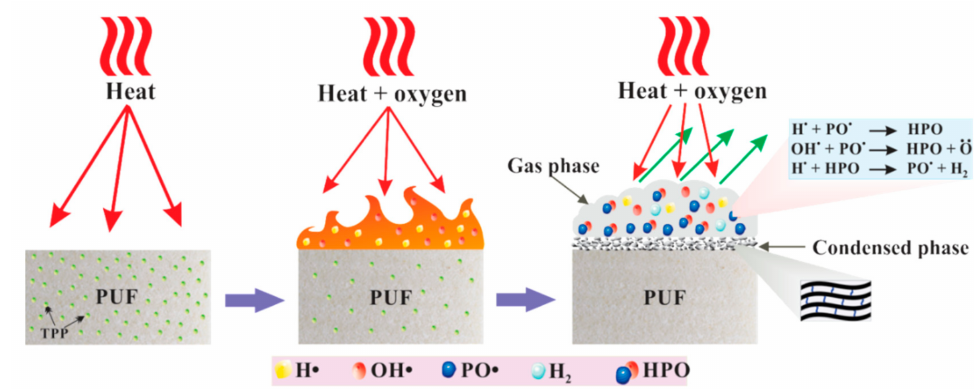
Figure 11. Schematic illustration of the flame-retardant mode of action of PU-DZS-TPP 25